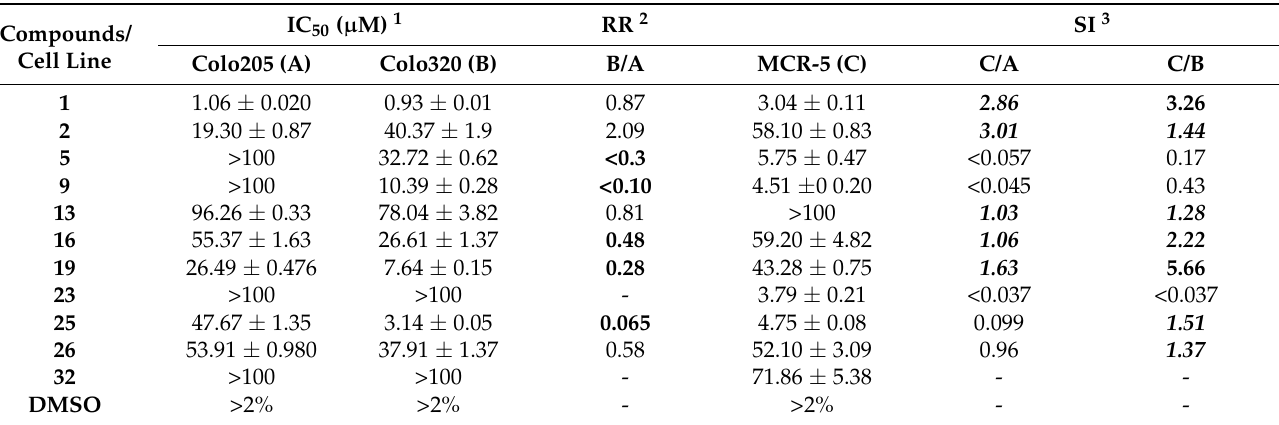
Table 1. Antiproliferative activity of compounds 1 – 32 in human colon adenocarcinoma cells (Colo 205, sensitive and Colo 320, resistant) and normal embryonal fibroblast (MRC-5) cell